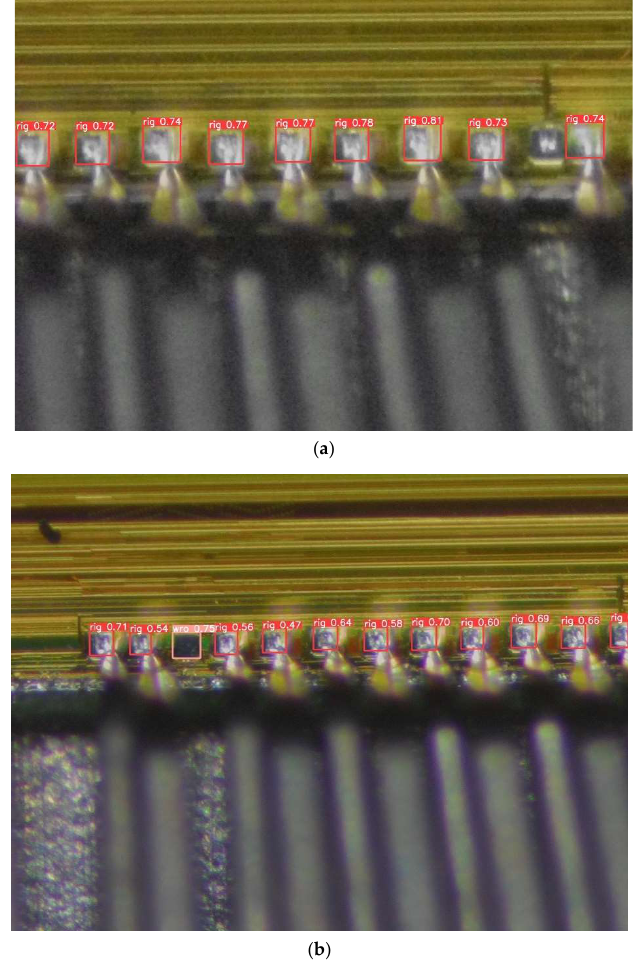
Figure 9. ( a , b ) Our method.